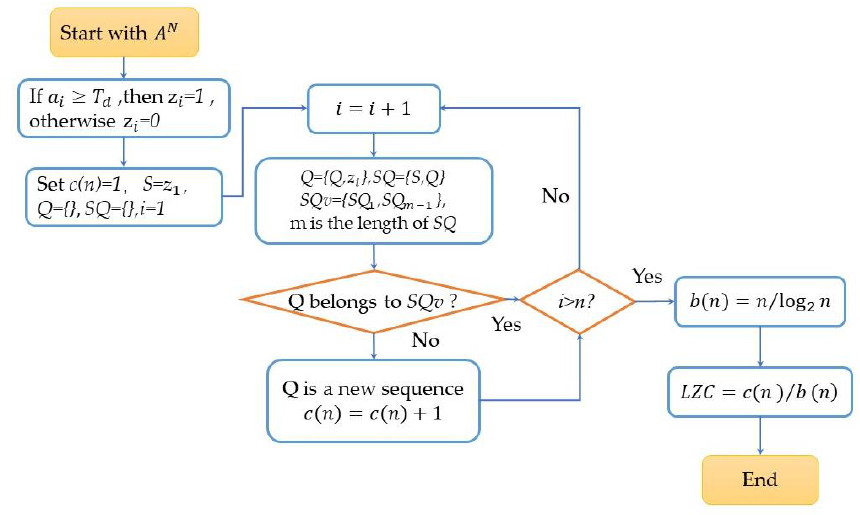
Figure 3. The nonlinear analysis computation process of Lempel – Ziv complexity ( LZC ).